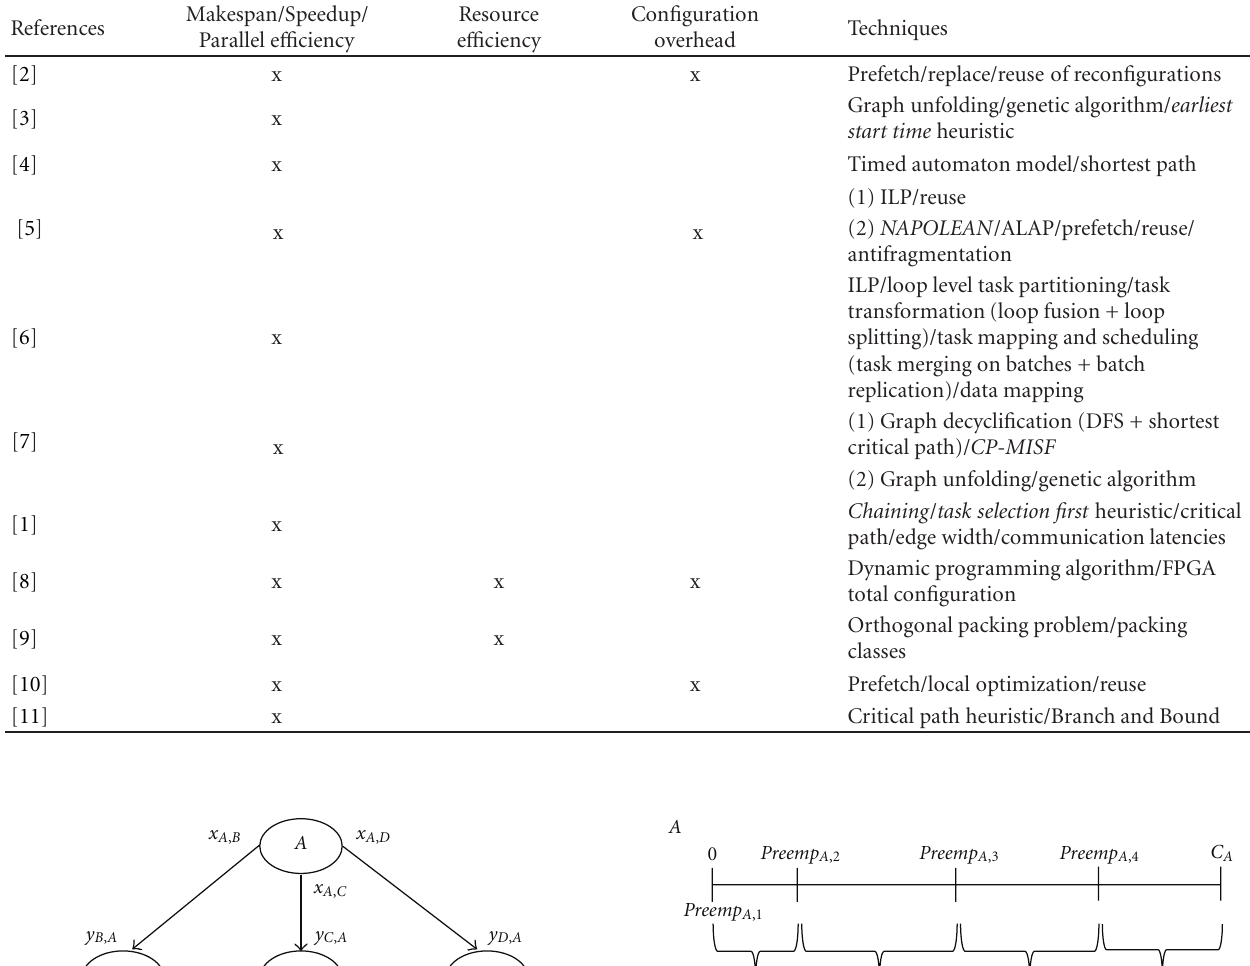
Table 1: Optimization parameters and techniques for scheduling works.